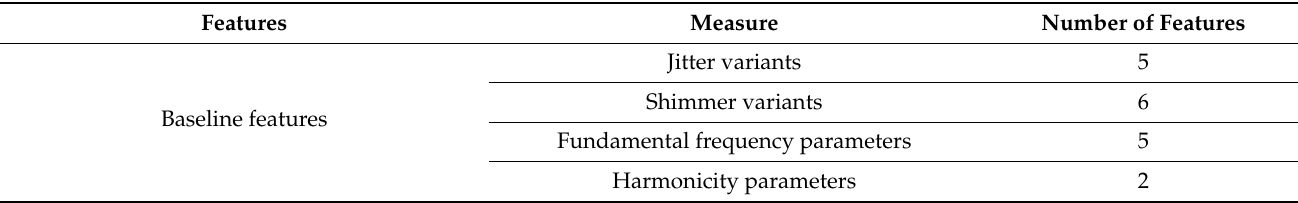
Table 1. Parkinson’s speech dataset